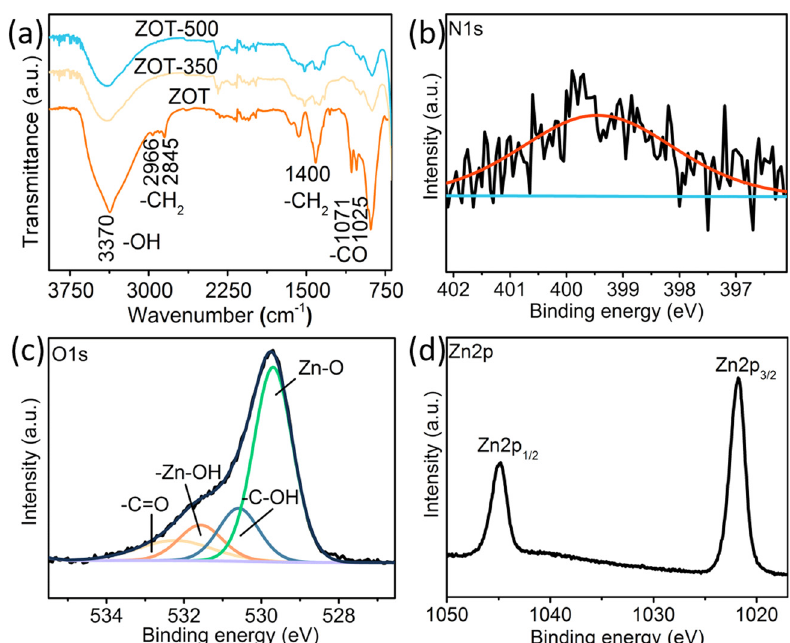
Figure 3: FTIR spectra of the samples and bonding energy of the ZOT spheres: ( a ) FTIR spectra of the ZOT, ZOT - 350, and ZOT - 500 samples; ( b ) XPS spectrum of N in the ZOT spheres; ( c ) XPS spectrum of O in the ZOT spheres; and ( d ) XPS spectrum of Zn in the ZOT